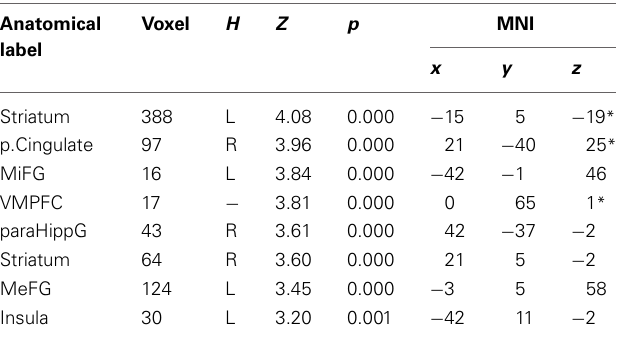
Table 3 | Effect of regulation DOWN < LOOK < UP for unfair and mid